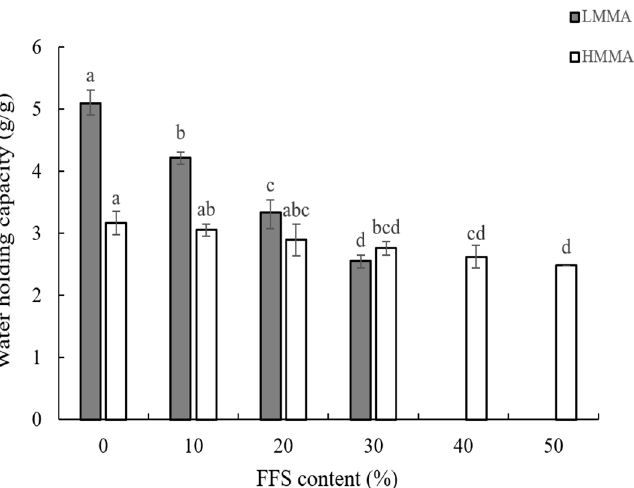
Figure 2. Water holding capacity of meat analogs with various full-fat soy (FFS) contents. LMMA: low-moisture meat analog; HMMA: high-moisture meat analog. Different letters (a–d) above the bars indicate the significantly different for each extrusion type (LMMA and HMMA) ( p ≤ 0.05) by Duncan’s multiple range tests